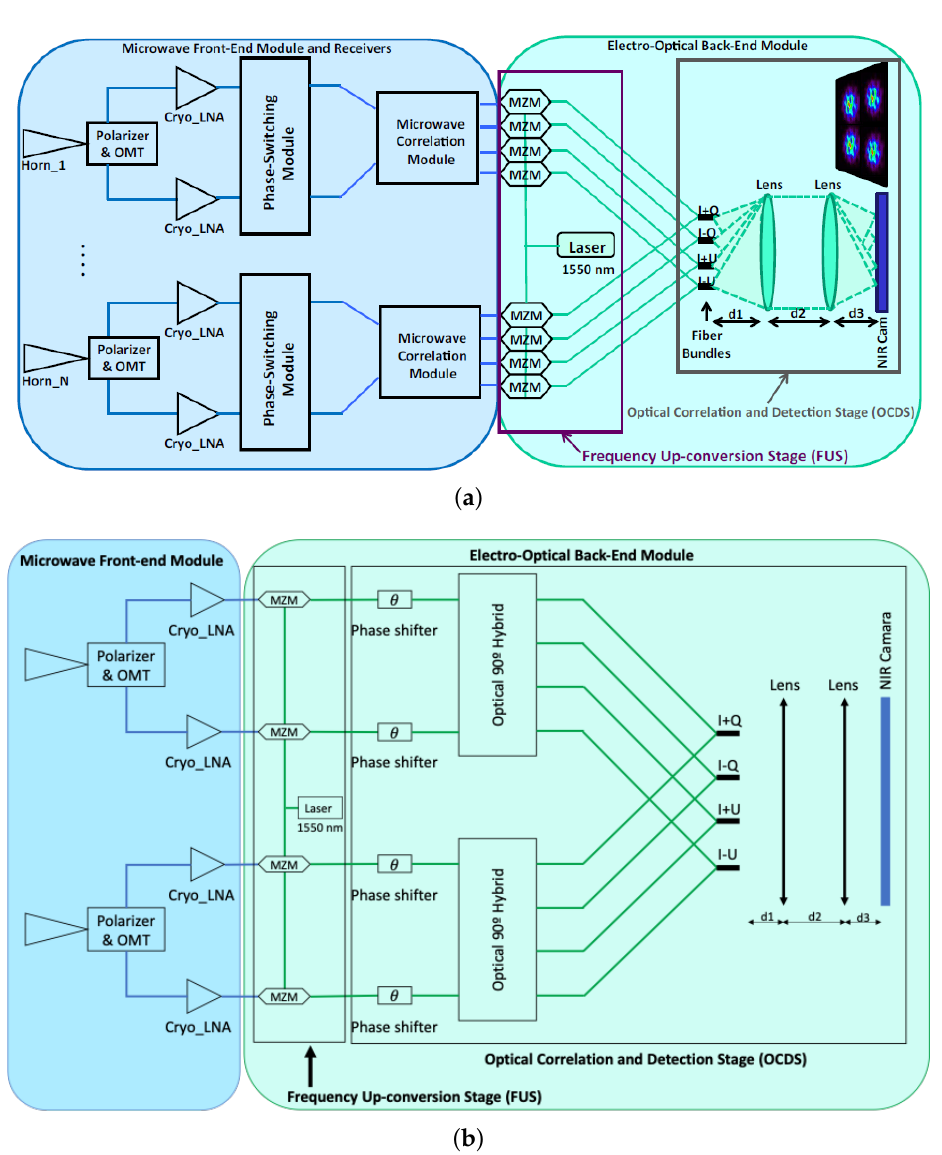
Figure 1. Simplified block diagram of the two microwave polarimeter for N receivers with near- infrared (1550 nm) correlation. ( a ) Microwave polarimeter previously proposed and reproduced with permission from F. J. Casas, Sensors; published by MDPI, 2019 [17]; ( b ) optimized version.